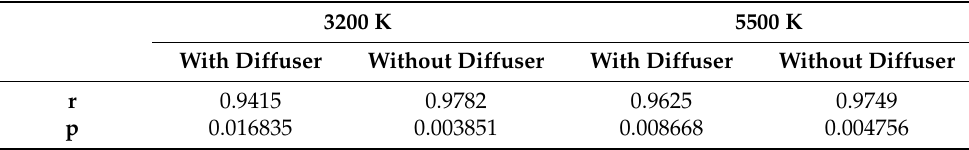
Table 9. Results of Pearson correlation coefficient between the 3200 K and 5500 K with and without diffuser. 3200 K 5500 K With Diffuser Without Diffuser With Diffuser Without Diffuser r 0.9415 0.9782 0.9625 0.9749 p 0.016835 0.003851 0.008668